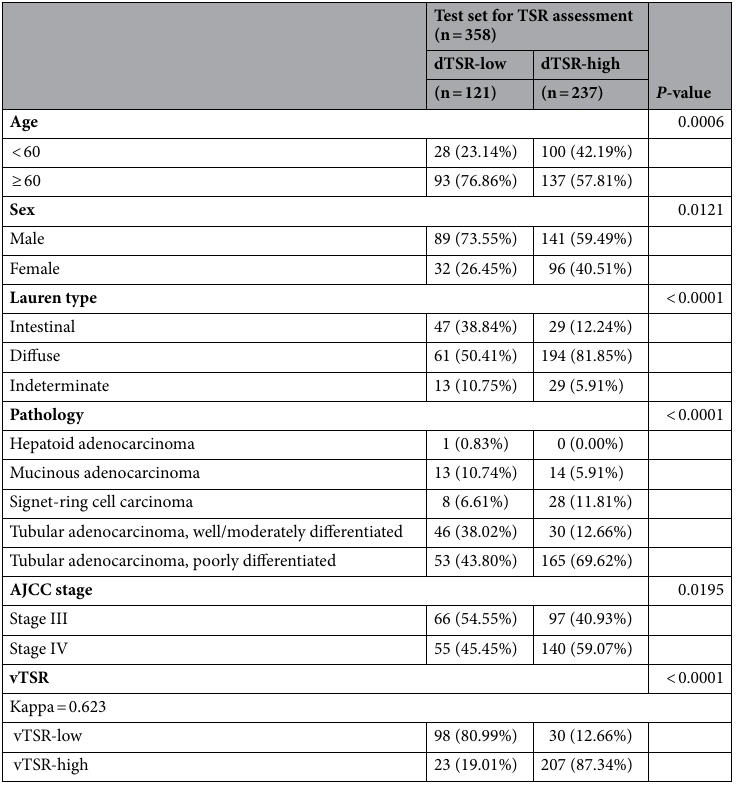
Table 2. Correlations between dTSR and vTSR and corresponding clinicopathologic characteristics.